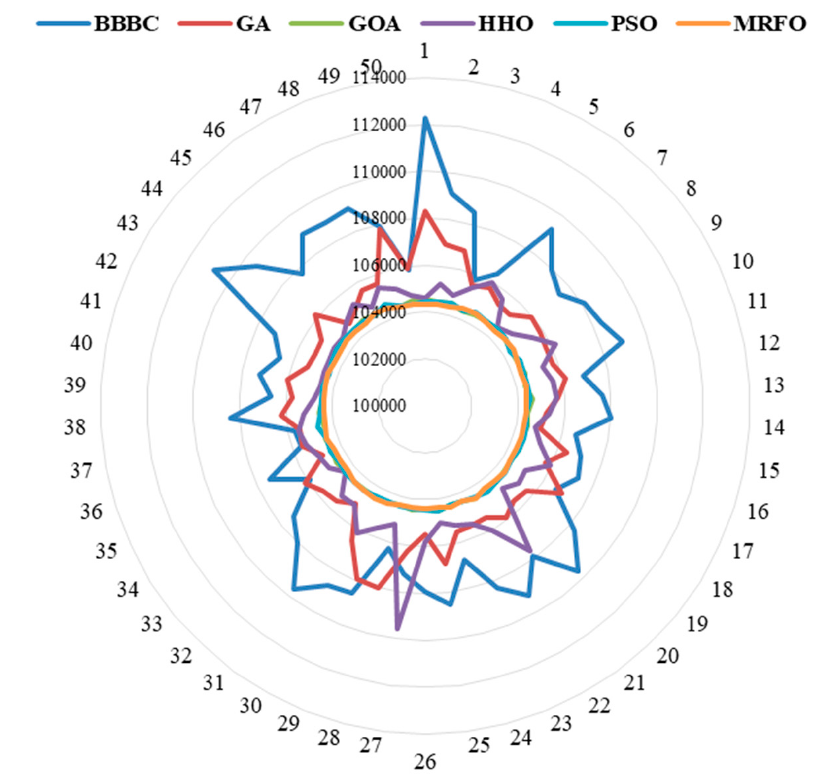
Figure 10. ASC vs. runs using MRFO in comparison to the other five intelligent algorithms for LPSP = 0%.